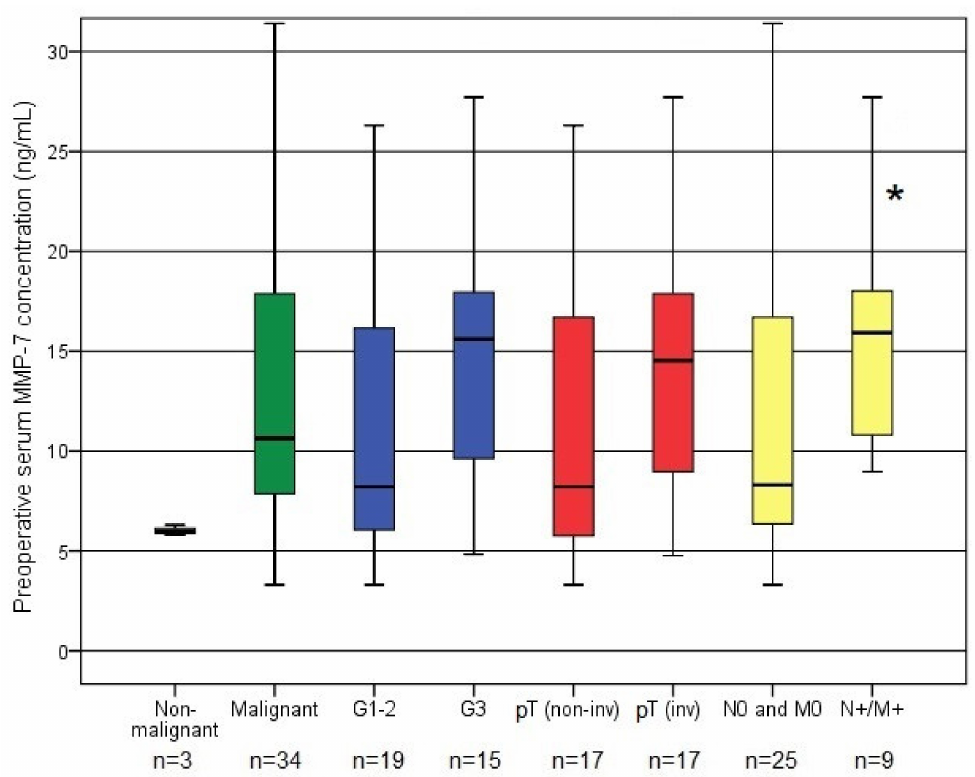
Figure 1. Association of preoperative serum MMP-7 concentration and clinicopathological parameters in the RNU cohort (* significant